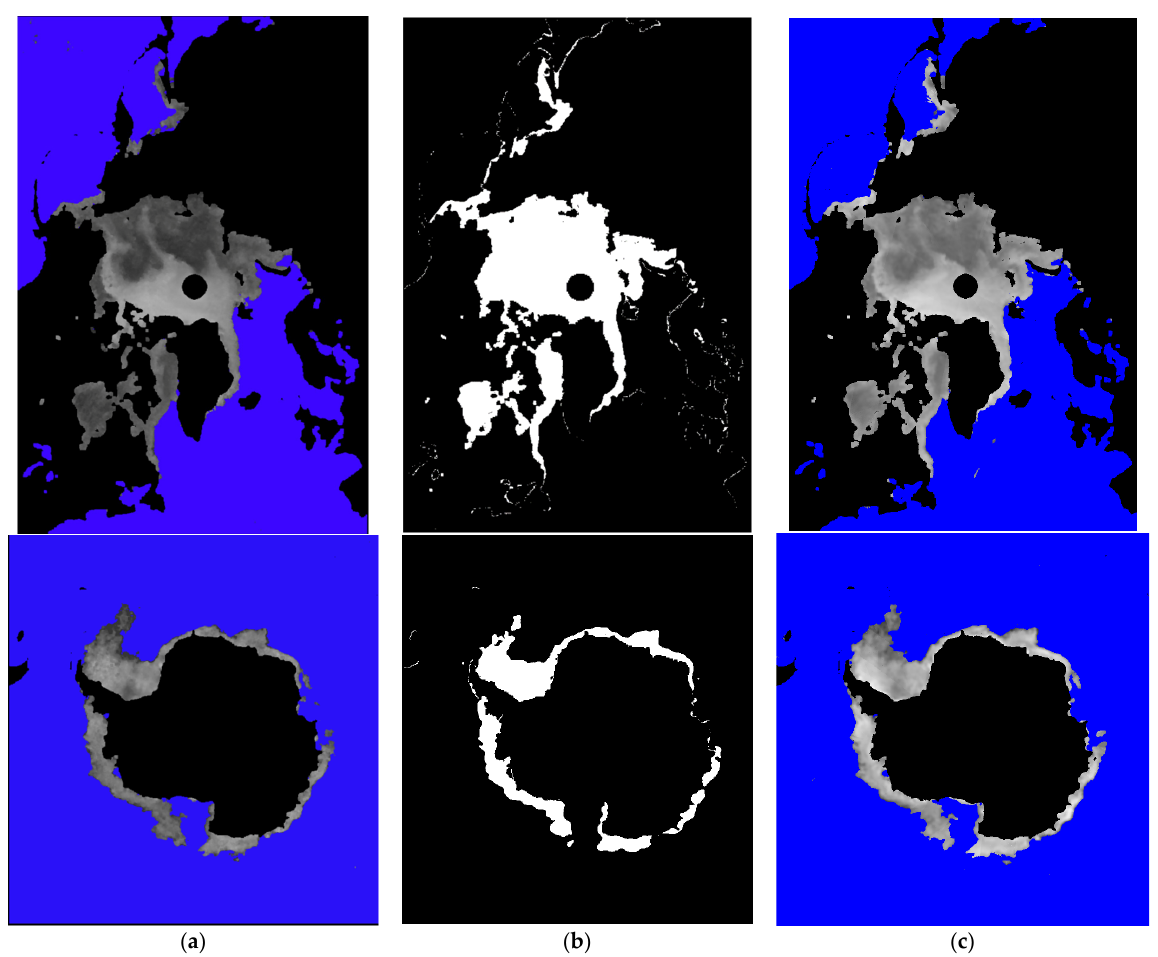
Figure 10. Sea ice extents in the Arctic (upper panel) and Antarctic (lower panel) on 10 January 2019 with the same land mask and polar gap mask: ( a ) CSCAT; ( b ) SSMI; ( c ) ASCAT; the gray scale for ( a ) and ( c ) indicates sea ice age/brightness. The grey scale for ( a ) and ( c ) represents sea ice normalized VV backscatter and map griding is 12.5 km.